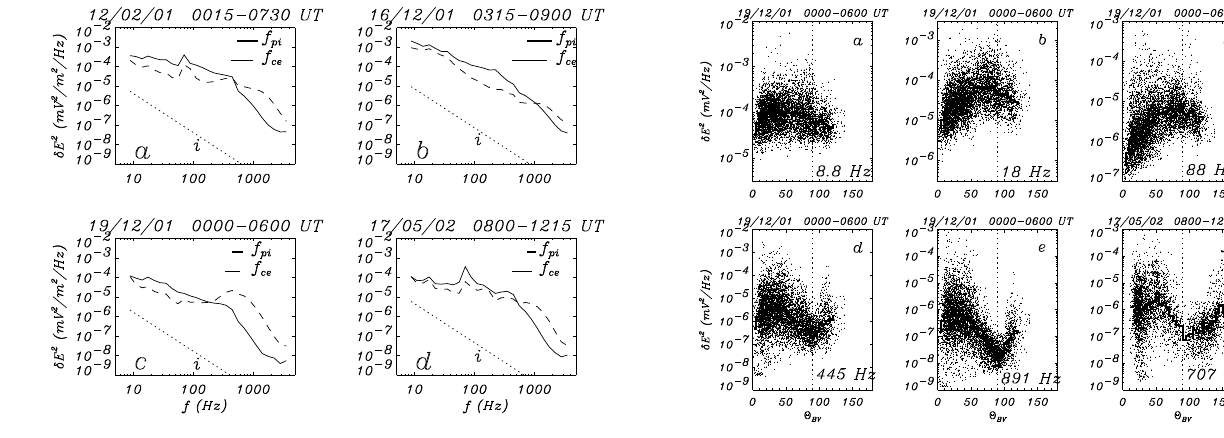
2 ◦ < Θ BV < 2 ( f ) Figure5:S atterplotsof δE asafun tionoftheangle Θ BV .Day19/12/2001: Figure4:Averagepowerspe traldensity δE forlargeangles( 65 115 ◦ ,solidline)andforsmallangles( Θ BV < 25 ◦ , Θ BV > 155 ◦ ,dashedlines), a)at f =8.8Hz;b)18Hz; )88Hz;d)445Hz;e)891Hz.Day17/05/2002: ◦ f)707Hz.Thethi klinegivesthemedianvalueforbins 5 wide. forthefour onsideredintervals.Thedottedline i givesanestimationofthe − 2 Fig. 4. Average power spectral density δE 2 (f ) for large angles Fig. 5. Scatter plots of δE 2 as a function of the angle 2 BV . 19 De- ba kgroundimpa tnoiseontheantenna,whi hvarieslike f .Thehorizontal barsatthetopofea h(cid:28)guregivetherangeofprotonplasmafrequen ies f pi and (65 ◦ <2 BV < 115 ◦ , solid line) and for small angles ( 2 BV < 25 ◦ , cember 2001: (a) at f =8.8Hz; (b) 18Hz; (c) 88Hz; (d) 445Hz; (e) ofele tron y lotronfrequen ies f ce foundduringtheinterval. 2 BV > 155 ◦ , dashed lines), for the four considered intervals. The 891Hz. 17 May 2002: (f) 707Hz. The thick line gives the median dotted line i gives an estimation of the background impact noise on value for bins 5 ◦ the antenna, which varies like f − 2 . The horizontal bars at the top of each figure give the range of proton plasma frequencies f pi and of electron cyclotron frequencies f ce found during the interval. 5